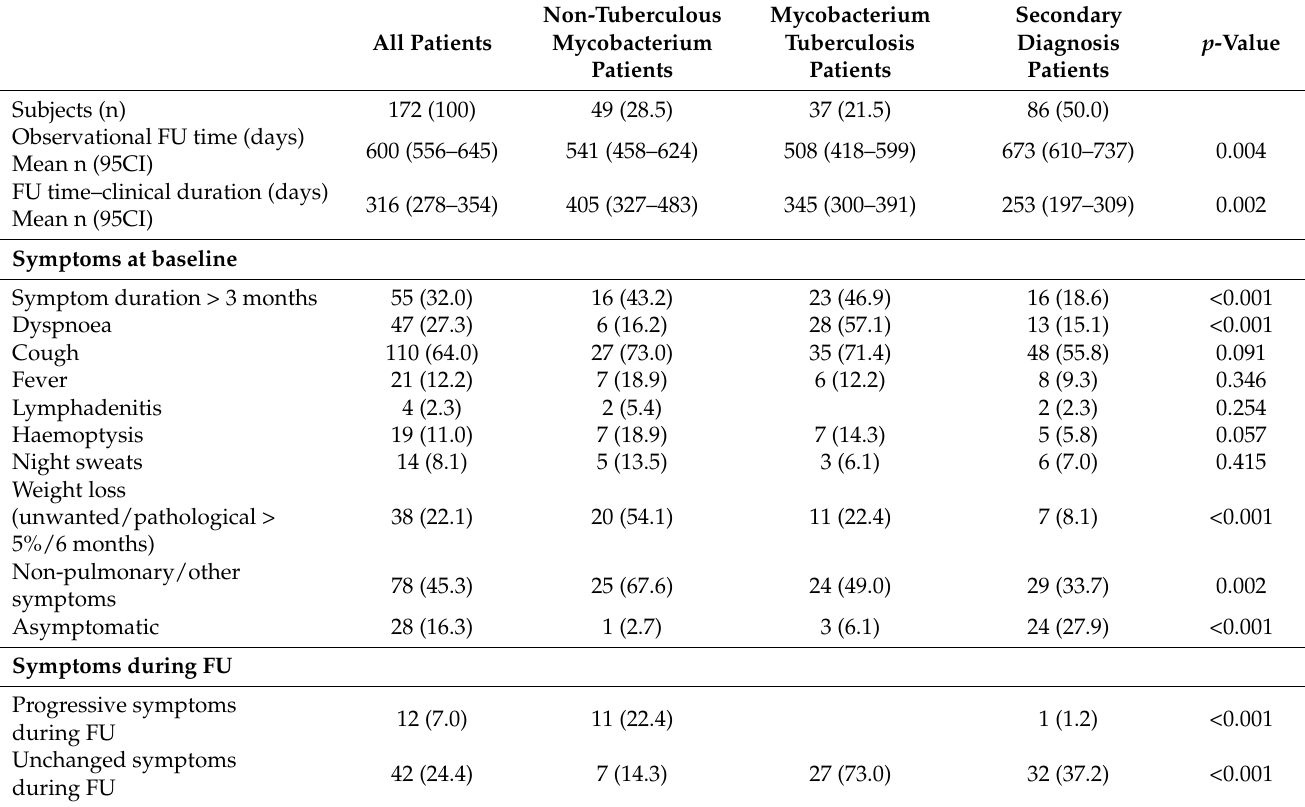
Table 3. Diagnostic and investigatory